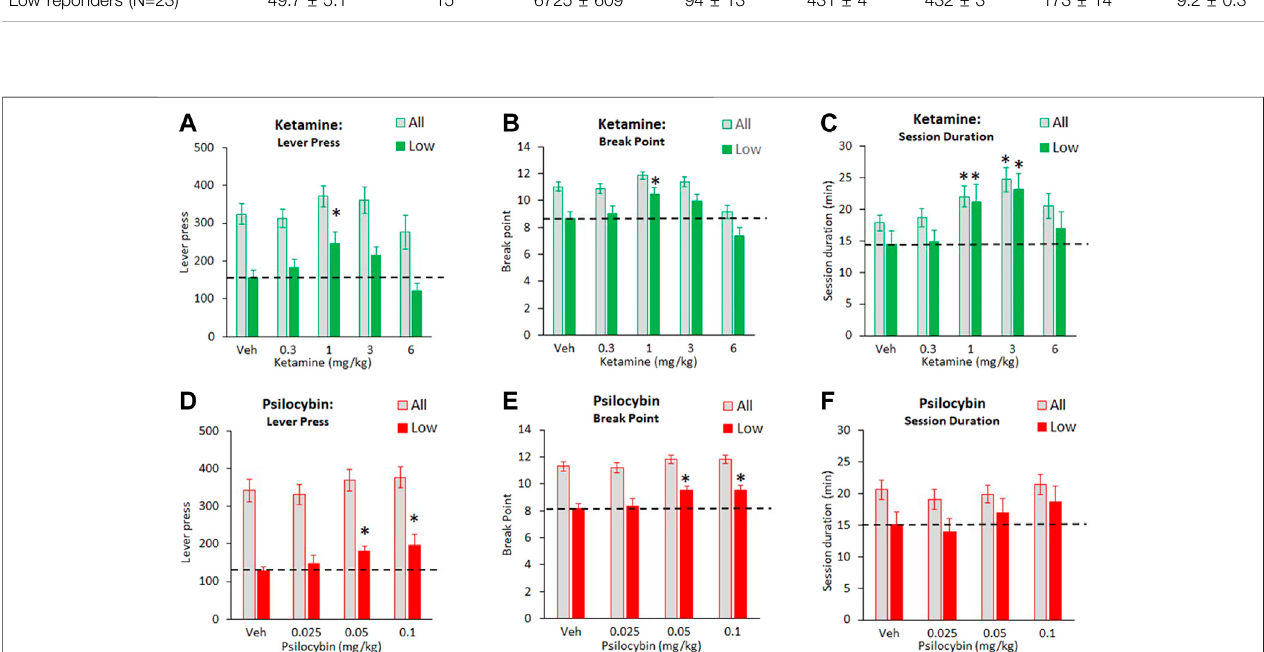
FIGURE2| Characterisationofketamine(0.3 – 6 mg/kgIP)andpsilocybin(0.025 – 0.1 mg/kgSC)onfoodrespondingmadeavailableunderaprogressiveschedule of reinforcement. Data is presented for both drugs as total number of lever presses recorded during the test session (A and D) , fi nal break point (B and E) , and total session duration (C and F) . Data for each drug is presented both as all test subjects (ketamine: N (cid:1) 68; psilocybin: N (cid:1) 72), and subjects characterized as “ low performers ” basedonhavingthelowesttertileonleverpresses/breakpointbasedonperformancemeasuredover7 dayspriortoonsetofdrugtesting(ketamine:N (cid:1) 23; psilocybin: N (cid:1) 24). The hashed line is to highlight the level of the “ low performer ” subgroup following vehicle pretreatment. * p < 0.05 vs. vehicle control (Dunnetts test following signi fi cant